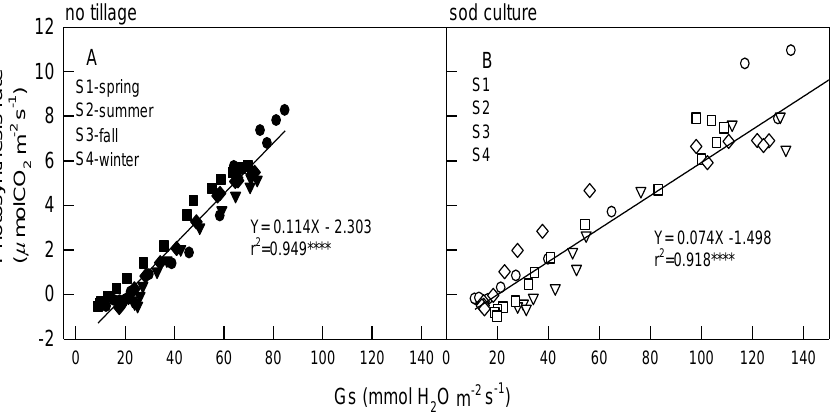
Figure 3. Correlations between Gs and Pnof citrus grown in NT (panel A ) and SC (panel B ) in four seasons (S1–S4 respective to spring, summer, fall, and winter) monitored from June 2019 to May 2020. Plants were subjected to light irradiations of 0, 5, 10, 15, 25, 50, 75, 100, 200, 400, 800, 1200, 1500, 1800, and 2000 μmol m −2 s −1 PPFD for 75 min. Each symbol represents the average of five leaves on one plant, and five plant s were randomly selected from tillage and season treatments. Each line represents the time point of 60 leaf values (four seasons multiplied by 15 PPFD) from the model’s validation datasets. The correlation coefficients (r) are calculated and significance ( p ) is at a 0.0001 probability (****) level.